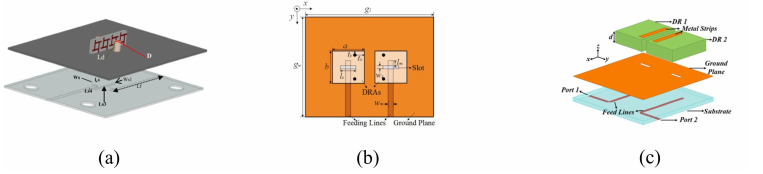
Figure 6. Configurations of MIMO antenna: ( a ) FSS wall [58]; ( b ) Metallic vias [59]; ( c ) Metal strips